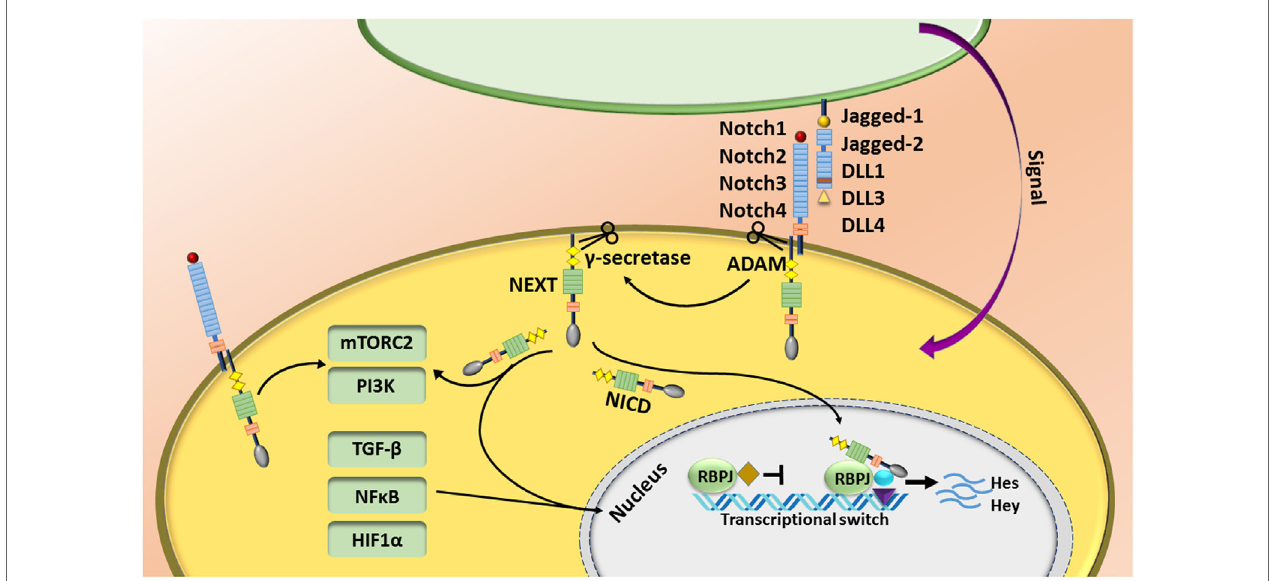
FigURe 1 | The Notch pathway is regulated by short-range cell–cell signaling. Notch is activated by interaction of one of the Notch receptors with its ligands and induces a sequence of proteolytic event leading to production of the Notch intracellular domain (NICD). NICD translocates to the nucleus, binds to the RBPJ complex, and recruits other transcriptional co-activators to initiate the transcription of target genes. Notch also regulates other target genes controlled by the TGF- β , NF κ B, mTORC2, and HIF1 α pathways.